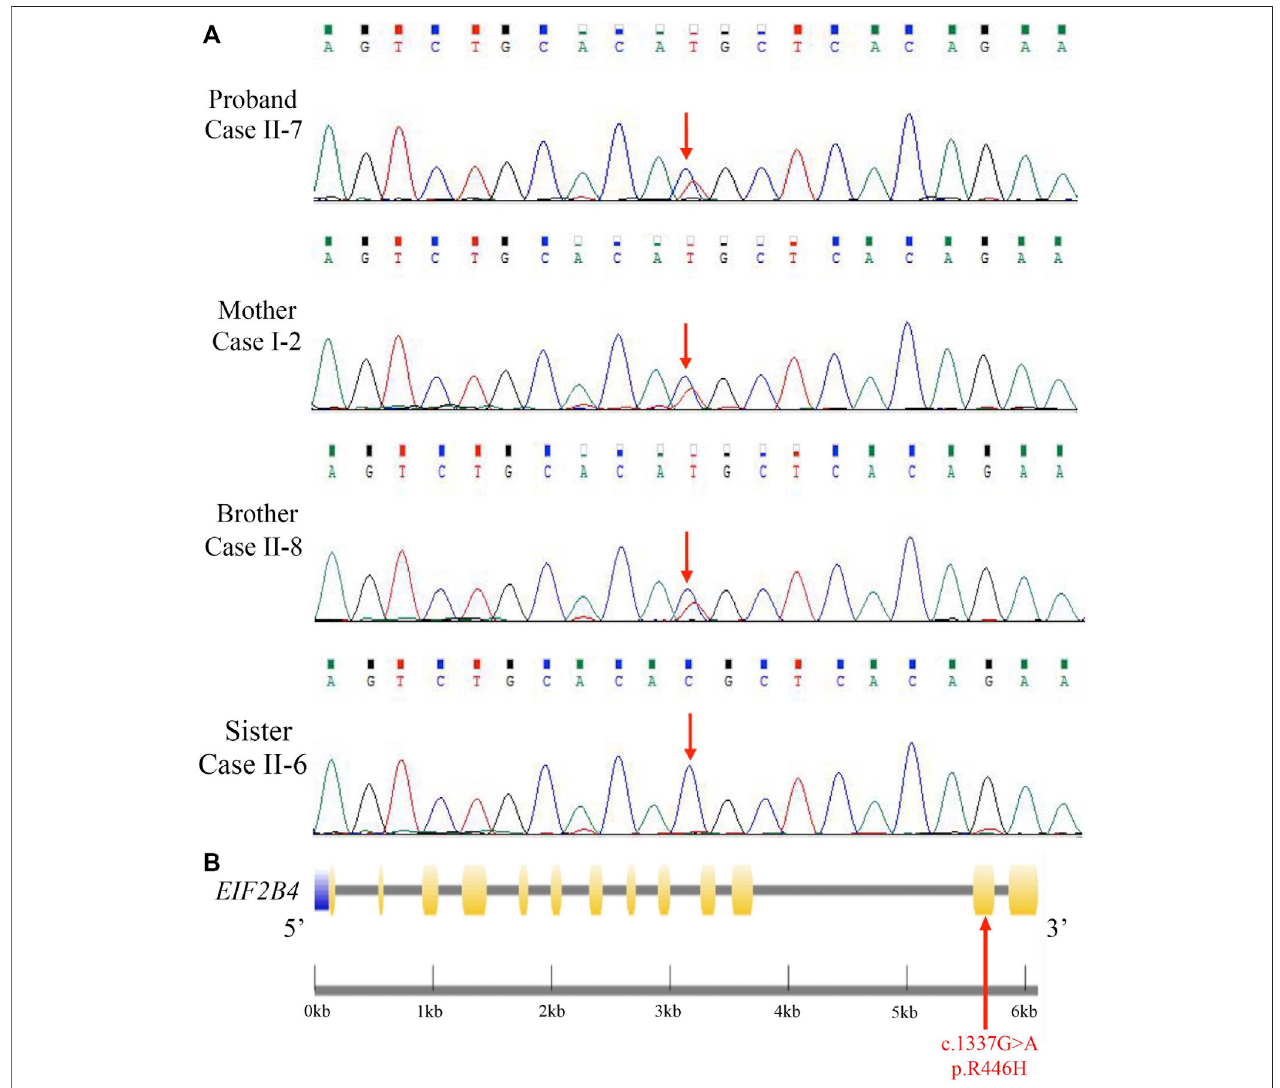
FIGURE2 | Identi fi cation ofanovel heterozygous EIF2B4 mutation. (A) Sanger sequencingvalidated amissensemutation(c.1337G > A[p. R446H]) inthe EIF2B4 gene in family members. (B) Schematic presentation of the EIF2B4 gene with an R446H substitution located in exon 12. Purple: upstream; yellow: exons; black line: